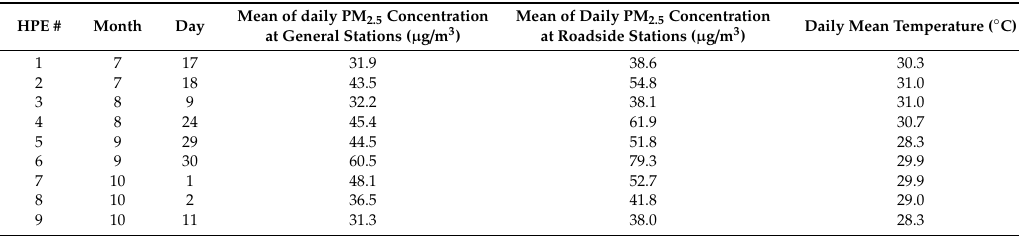
Table 1. Nine identified HPEs during 2019 with the mean daily PM 2.5 concentration ( µ g / m 3 ) at both general and roadside stations and daily mean temperature ( ◦ C).